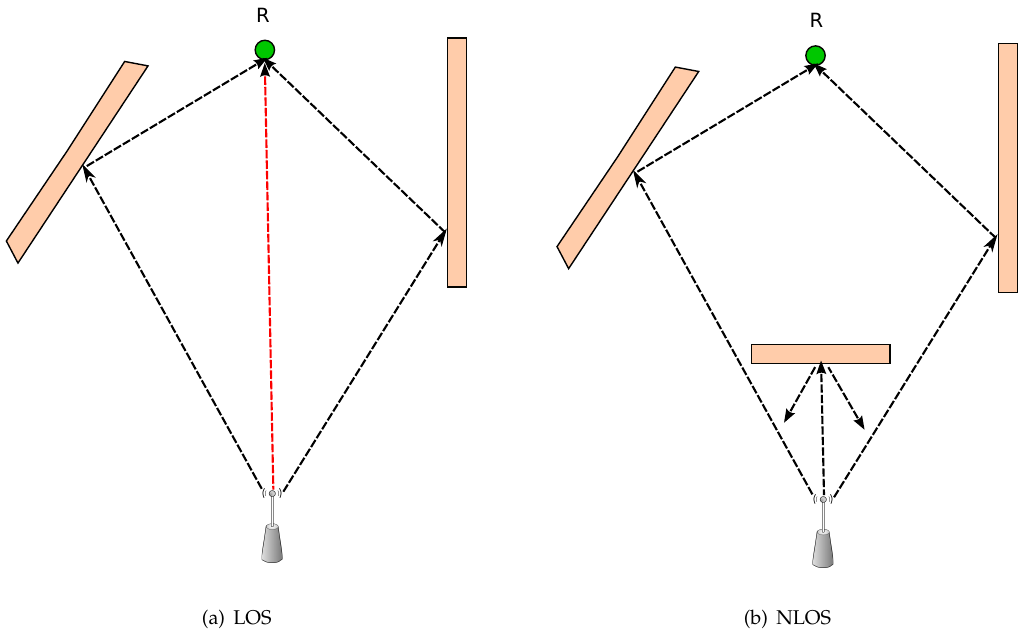
Figure 2. ( a ) Line-of-sight (LOS) vs . ( b ) non-line-of-sight (NLOS).